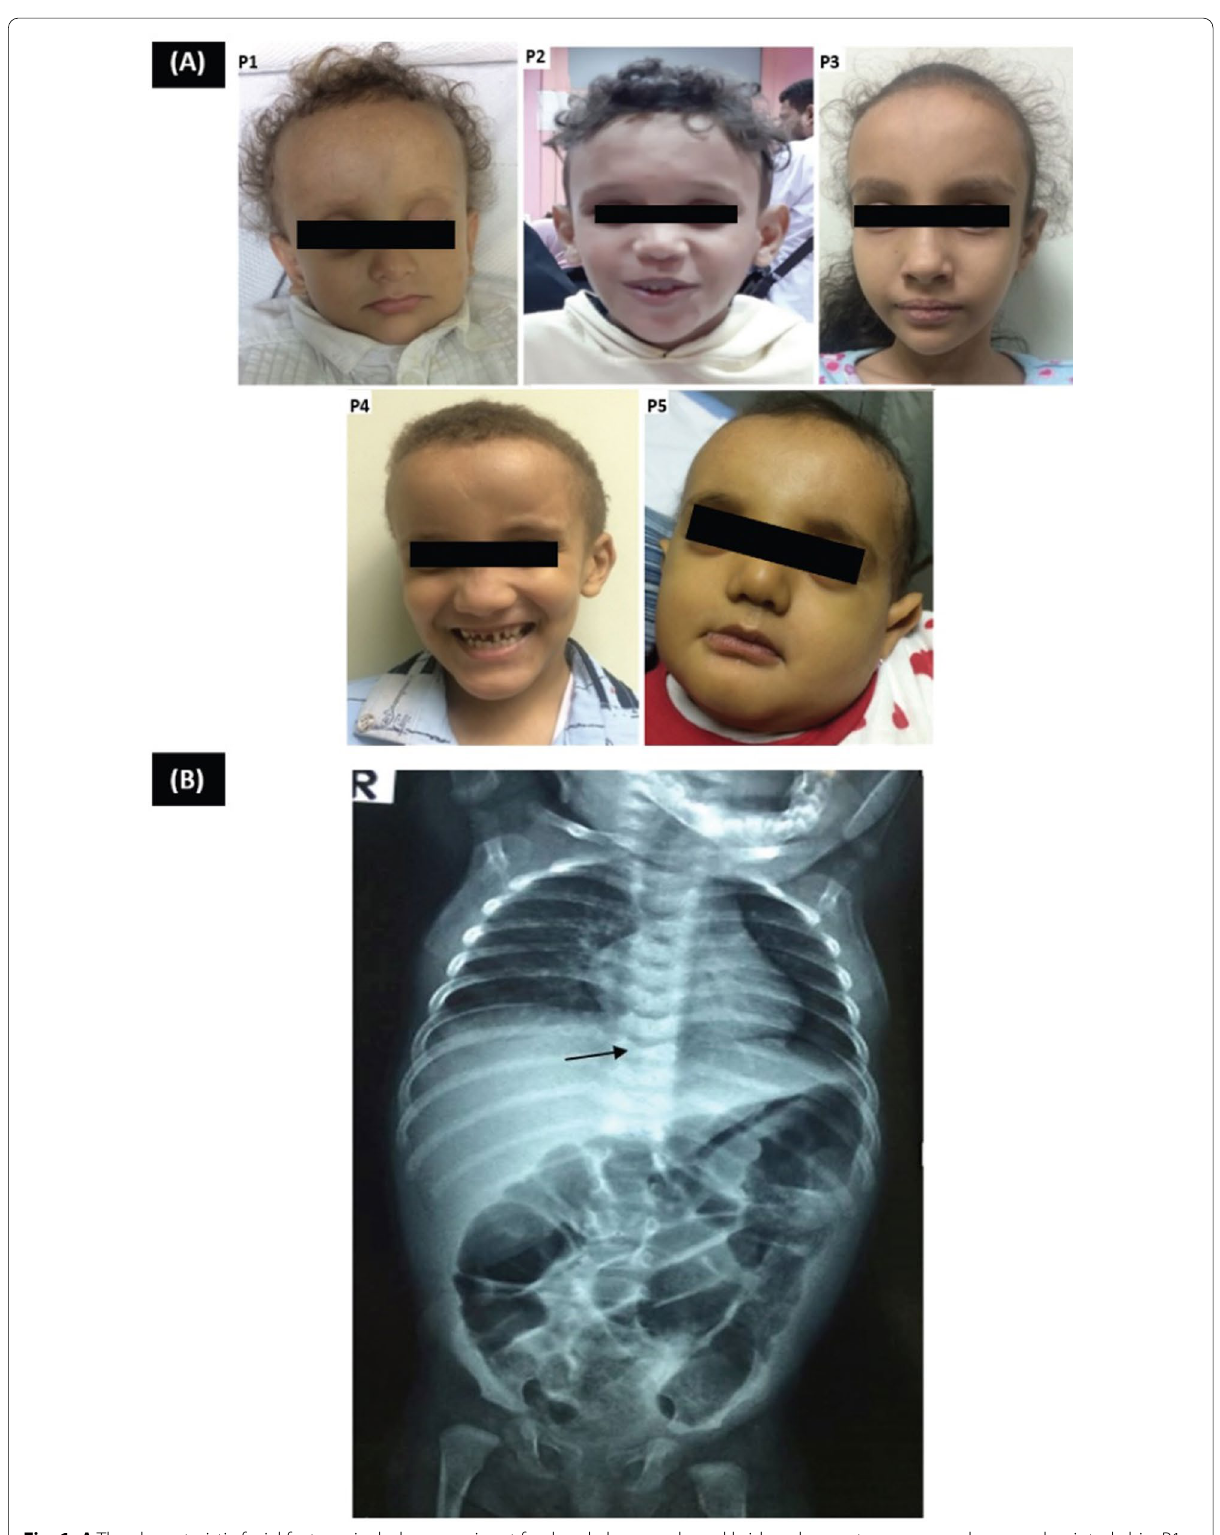
Fig. 1 A The characteristic facial features include a prominent forehead, depressed nasal bridge, deep‑set eyes, cupped ears, and pointed chin. P1– P5 is corresponding to patients 1–5, respectively. B X‑ray showing butterfly vertebrae (black